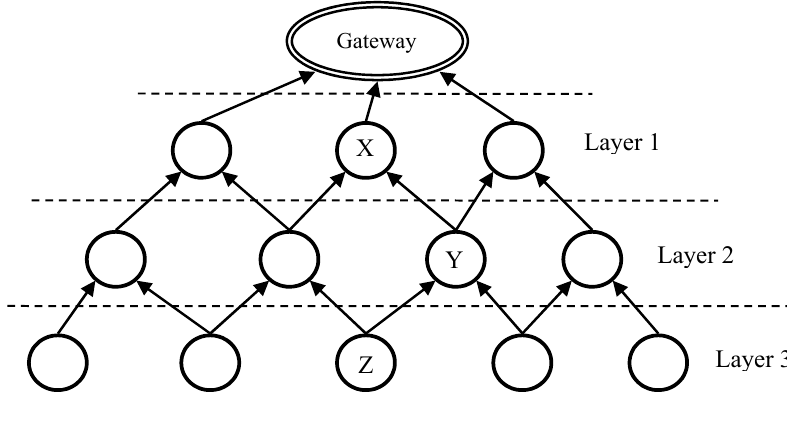
Figure 3. Layer routing in LBMR.